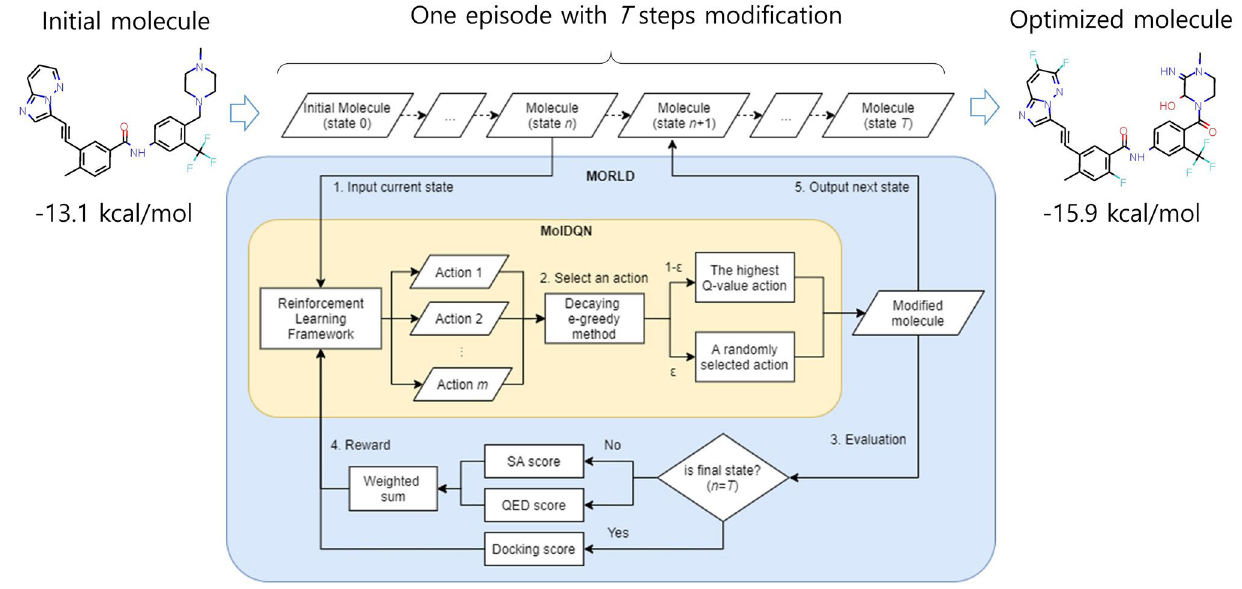
Figure 1. Schematic overview of the MORLD. An initial molecule is optimized by T steps of modifications (one episode) as shown in the flow chart. Through multiple episodes, MORLD learns a way of modifying molecules to create an optimized molecule having a higher docking score to the target